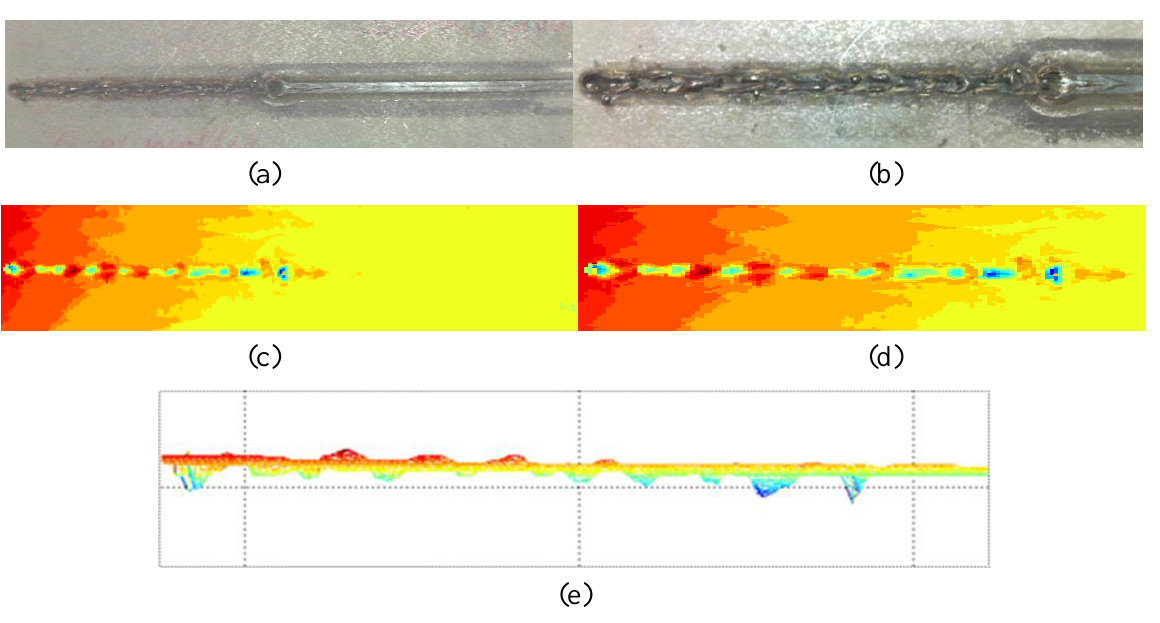
Figure 7. Results of weld quality inspection for laser welding: (a) weld as the inspection target; (b) detail of the weld; (c) top-view of the inspected weld; (d) detailed top-view of the inspected weld; (e) detailed side-view of the inspected weld.